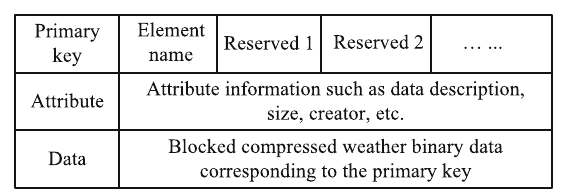
Fig. 5 The storage structure of meteorological common data